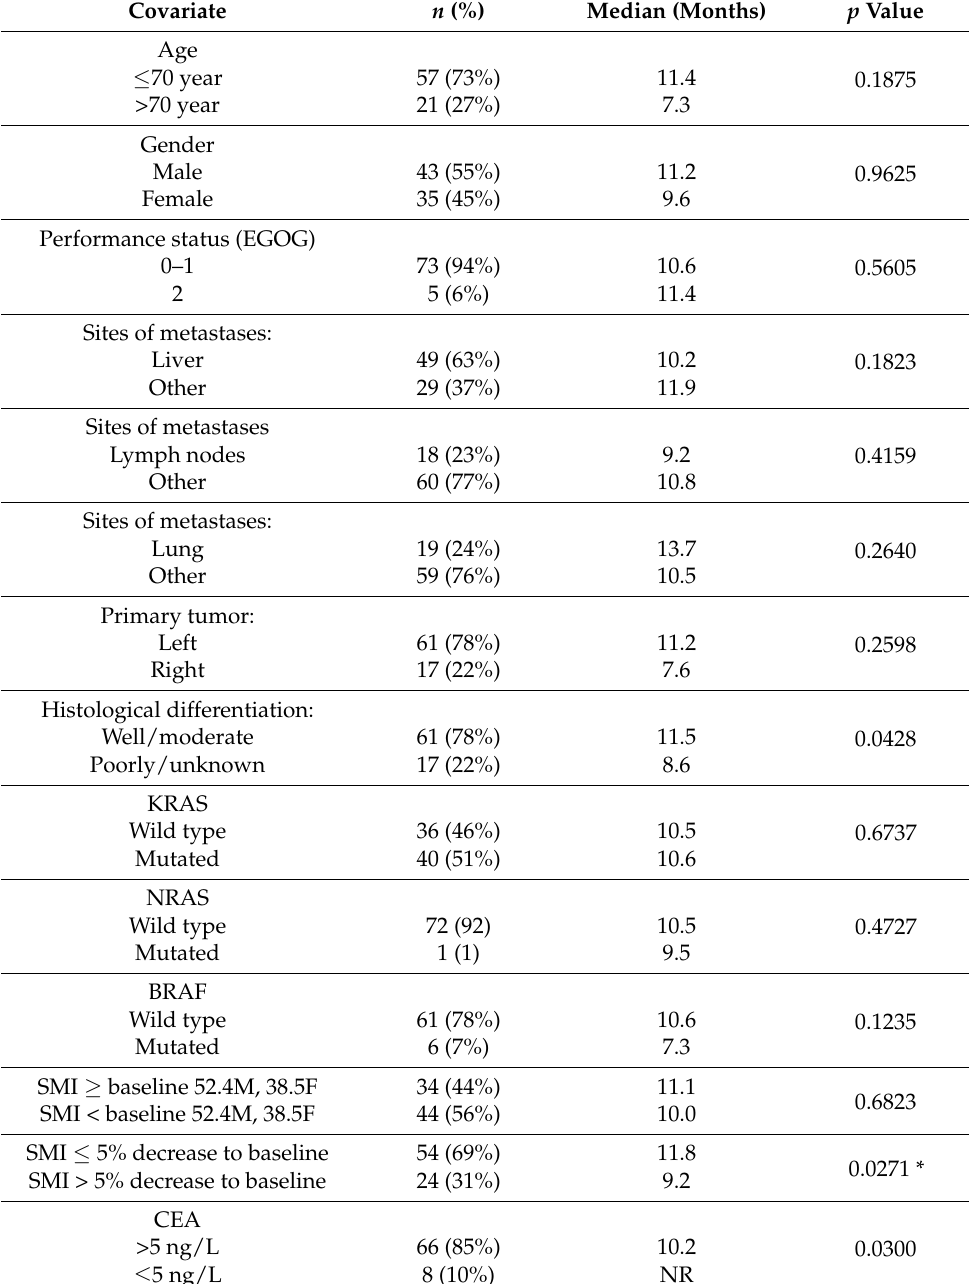
Table 5. Univariate analysis of overall survival (log-rank